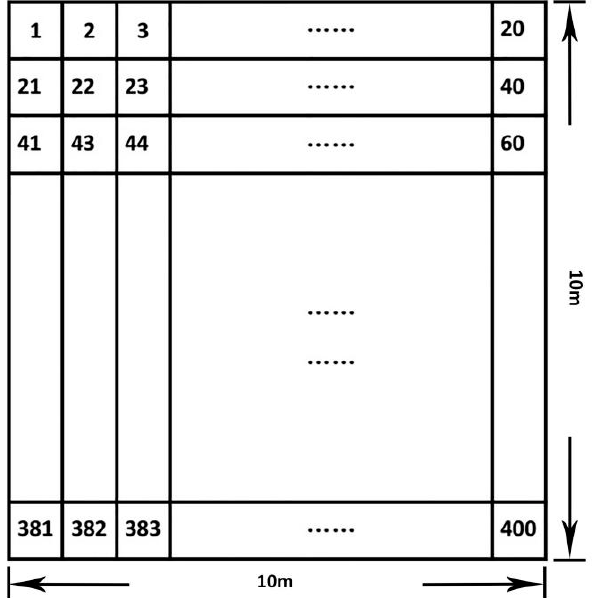
Figure 3. Diagram of each quadrat in sample plot. The sample plot is 10 m × 10 m and includes 400 sample quadrats, each measuring 0.5 m × 0.5 m, numbered from 1 to 400 and evenly distributed throughout the sample plot.